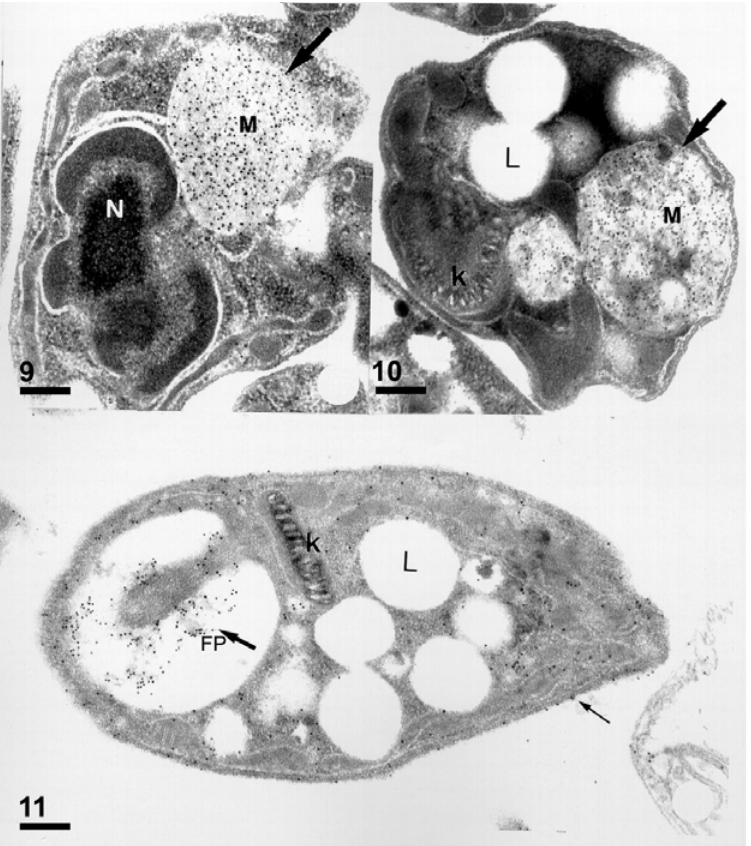
Figs. 9-11 – Immunocytochemical localization of cysteine proteinase in amastigotes of Leishmania amazonensis . This protein is stored in the megasomes (M) and secreted into the flagellar pocket. Labeling of the cell surface (arrow in figure 11) and of the cisternae of the endoplasmic reticulum is observed. FP, flagellar pocket; K, kinetoplast; L, lipidic inclusion; M, megasome. Bar, 0 . 25 µ m. Micrographs from T Ueda-Nakamura and W de